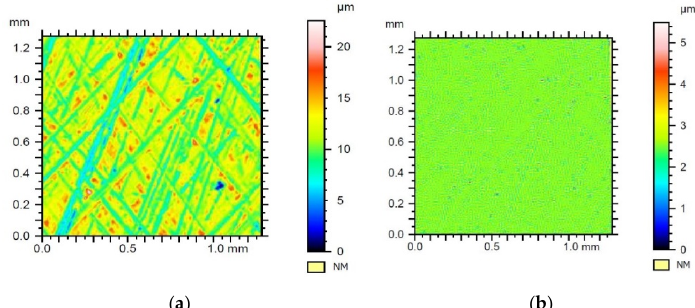
Figure 10. Results of filtration of the surface geometrical structure of sample no. 1 with Daubechies wavelet of the 3rd row on the 5th level of filtration—( a ) waviness, ( b ) roughness.